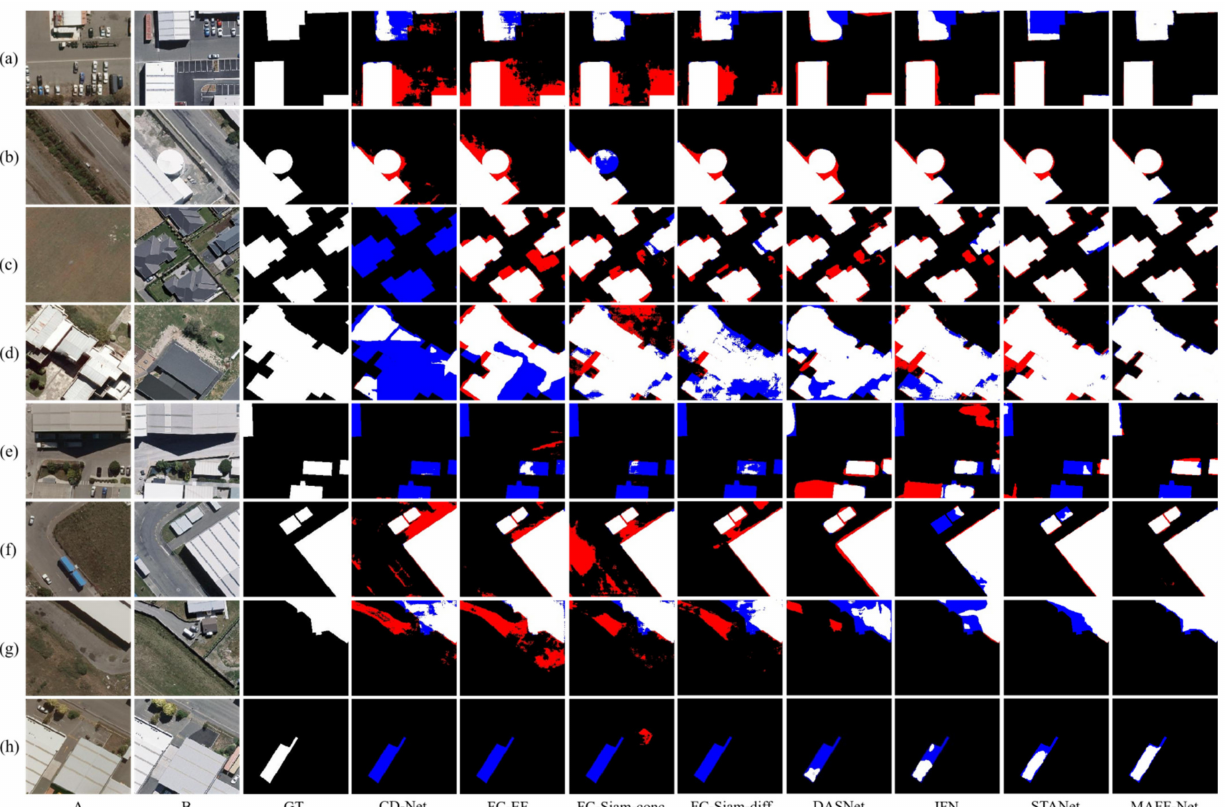
Figure 10. Illustration of a qualitative comparison on dataset WHU-CD. ( a – h ) indicate samples from WHU-CD and the change maps obtained with different methods. The white color indicates the changes that were correctly detected. Black indicates that no changes have been correctly detected. Red indicates false alarms. Blue indicates unpredicted